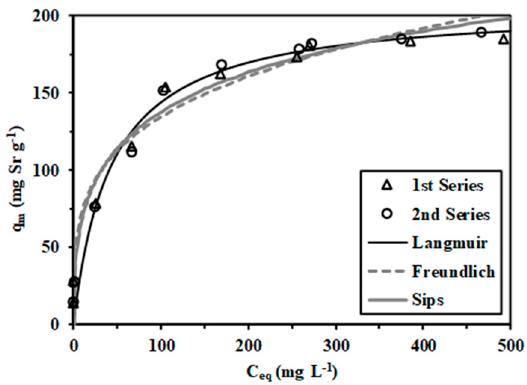
Figure 4. Sorption isotherms for Sr(II) removal using AO-APEI sorbent. Modeling (pH 0 : 6.0; pH eq : 7.1; SD: 0.2 g L − 1 ; temperature: 25 ± 1 ◦ C; contact time: 48 h; agitation speed: 140 rpm). SD: 0.2 g L − 1 ; temperature: 25 ± 1 °C; contact time: 48 h; agitation speed: 140 rpm).